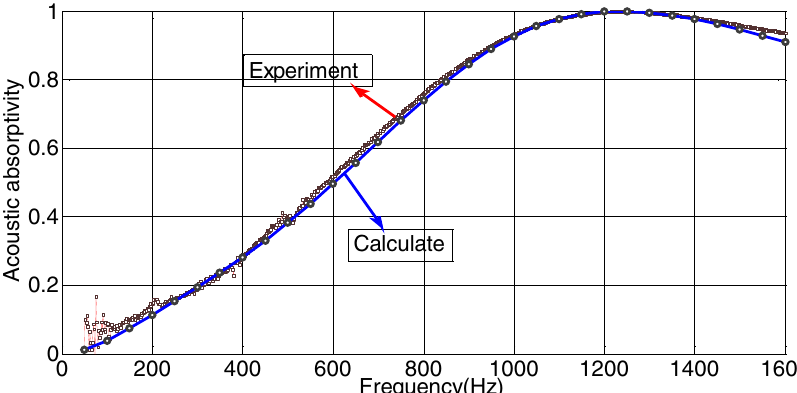
Figure 5: Comparison of experimental and simulation